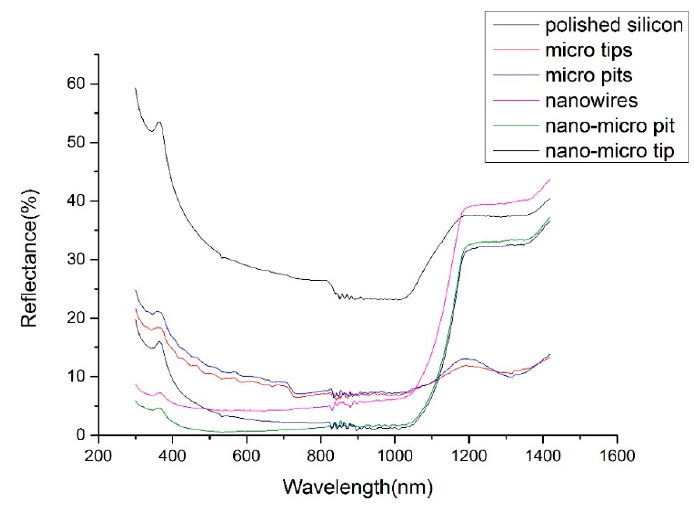
Figure 9. The reflectance spectrum results of polished silicon, micro tips, micro pits, nanowires nano-micro pit, and nano-micro tip structures.